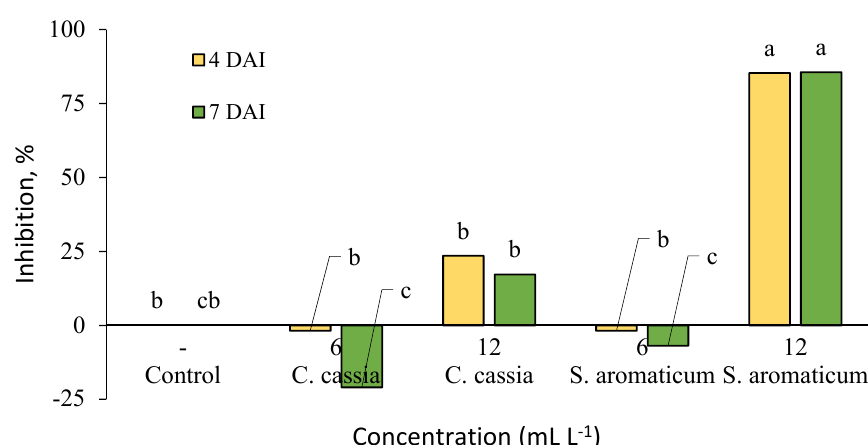
Figure 3. Infection of grey mould on detached strawberry leaves 7 days after inoculation, after treatment with ( a ) cinnamon ( C. cassia ) extract; ( b ) clove ( S. aromaticum ) extract.